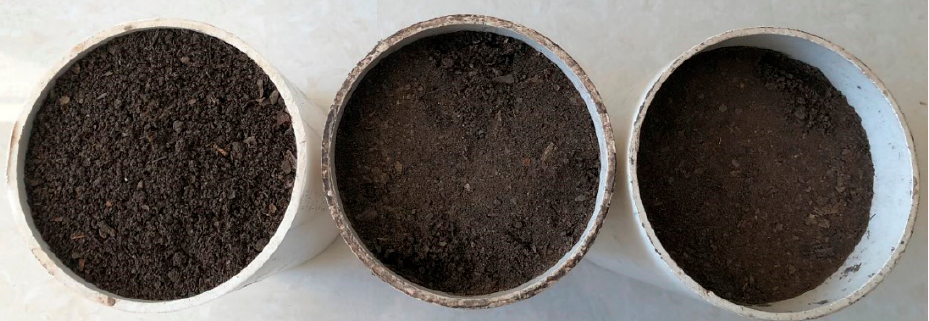
Figure 4. The same quality of humus samples with three compaction classes. The left, middle and right samples were incompact with zero blows per layer, slightly compacted with three blows per layer and strongly compacted with 15 blows per layer, respectively.